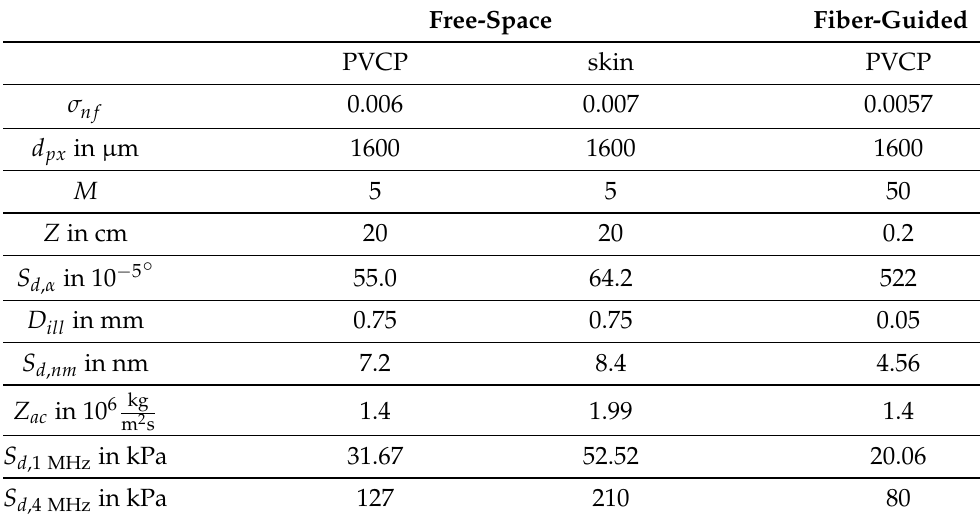
Table 2. Relevant parameters for the determination of S d , nm and S d for the established sensing